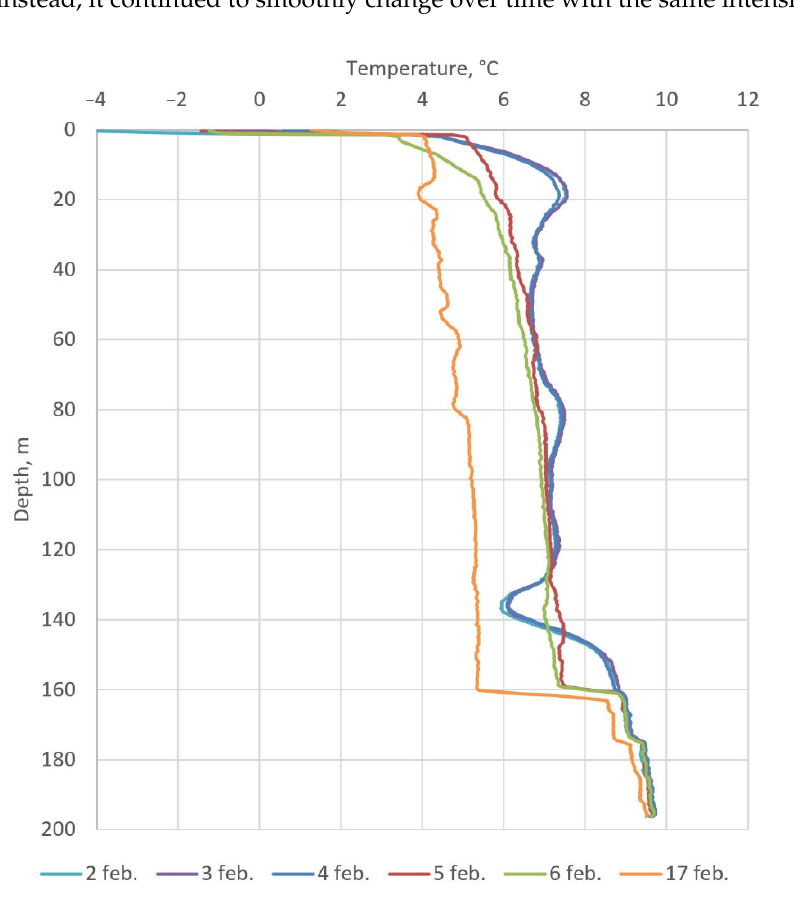
Figure 5. Abnormal temperature behavior in TM4 over time. Table 2. Comparative analysis of temperature measurements in TM4.